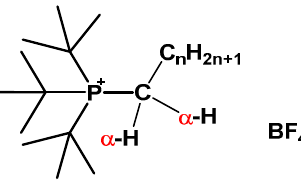
Figure 1. α -protons in the sterically hindered phosphonium salts.